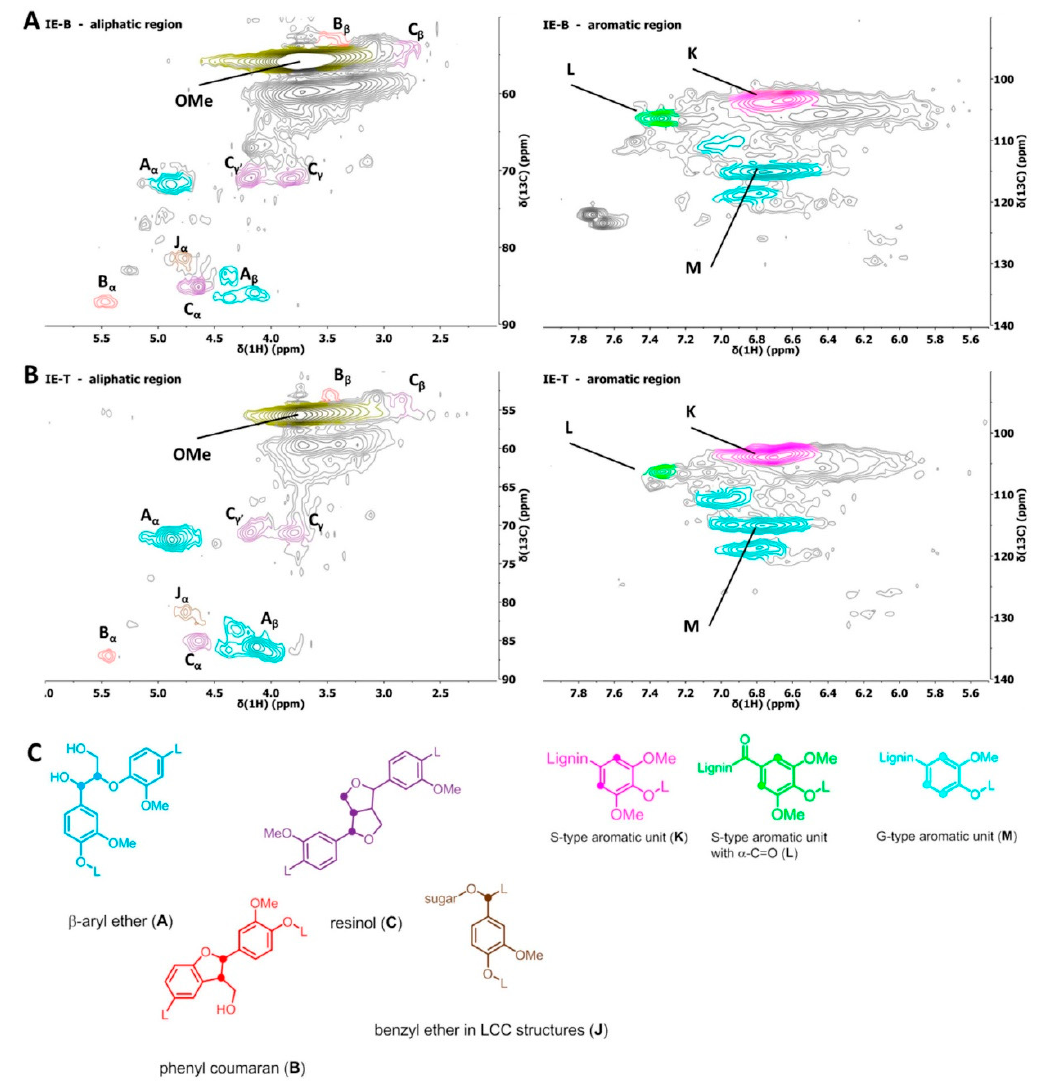
Figure 3. HSQC spectra of ( A ) IE B and ( B ) IE T . The aliphatic region is shown on the left, while the aromatic region is displayed on the right. ( C ) Important identified and colour-coded structural units.